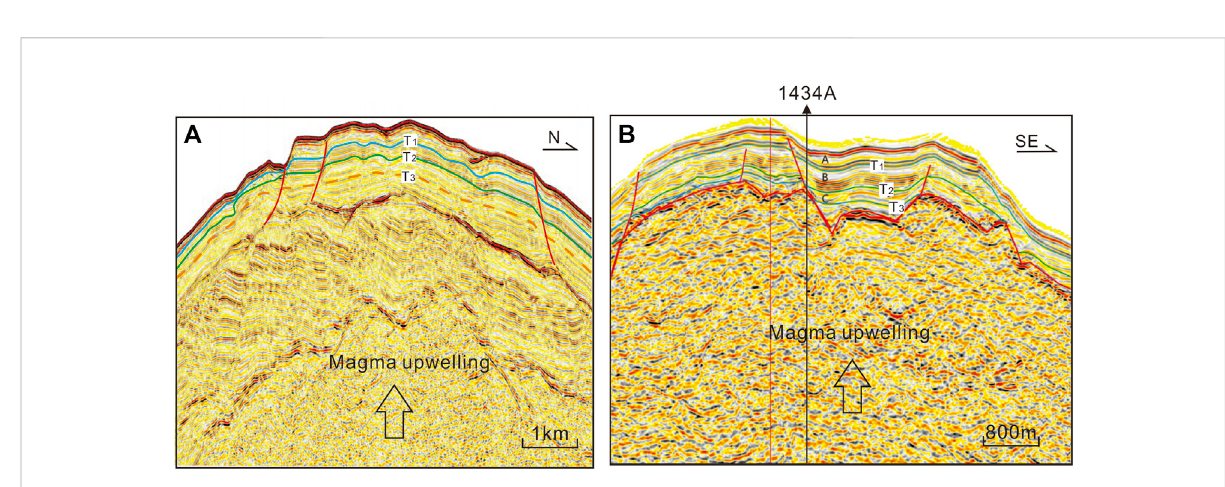
FIGURE 5 Seismic re fl ection characteristics between the Zhongjiannan Basin (A) and the U1434A drill of the SWSB (B) .The position of pro fi le a is shown in Box e in Figure 2A. The position of pro fi le b can be seen along survey Line A2 in Figure 1.